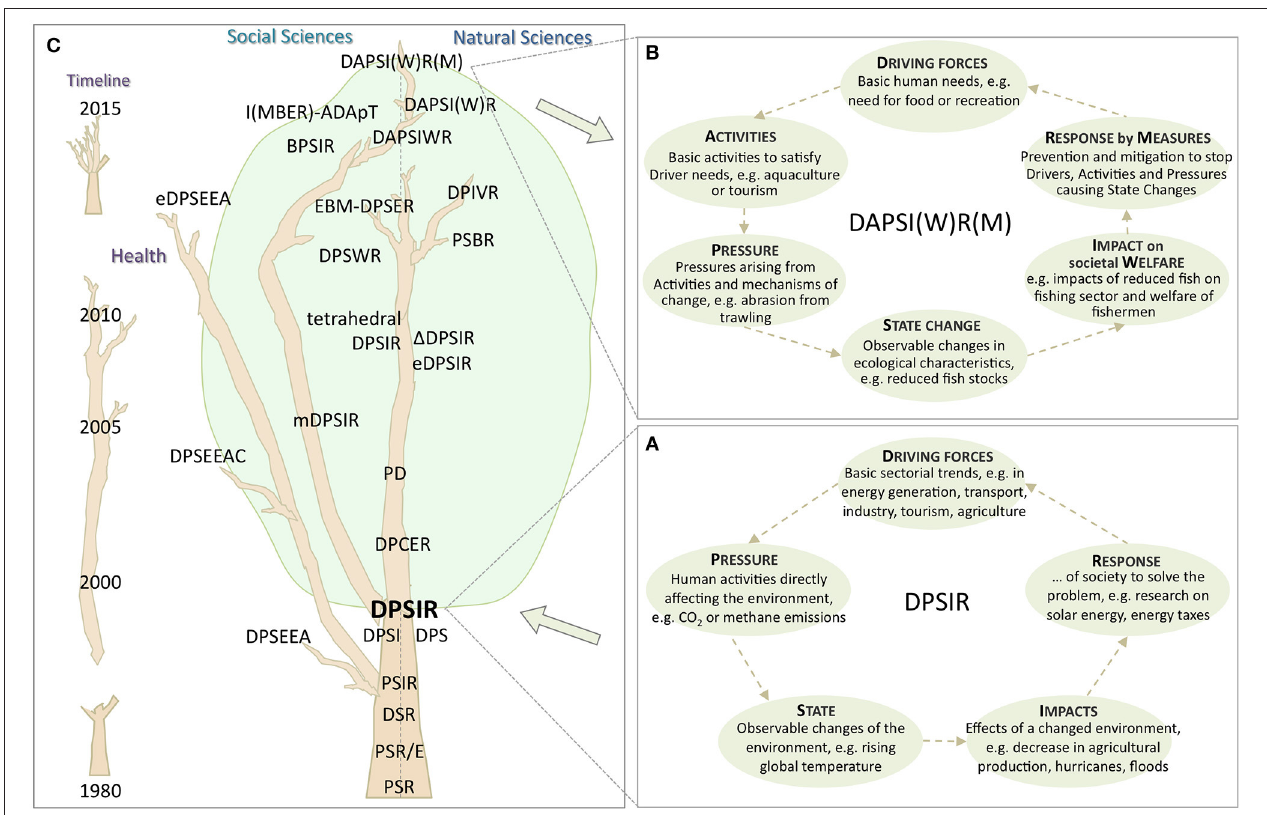
FIGURE 1 | DPSIR and derivatives development. (A) DPSIR first elaboration, redrawn from the original EU framework (EC, 1999), (B) DAPSI(W)R(M), top of the tree evolution of DPSIR (as defined in Scharin et al., 2016), (C) timeline and development/relationship of DPSIR and